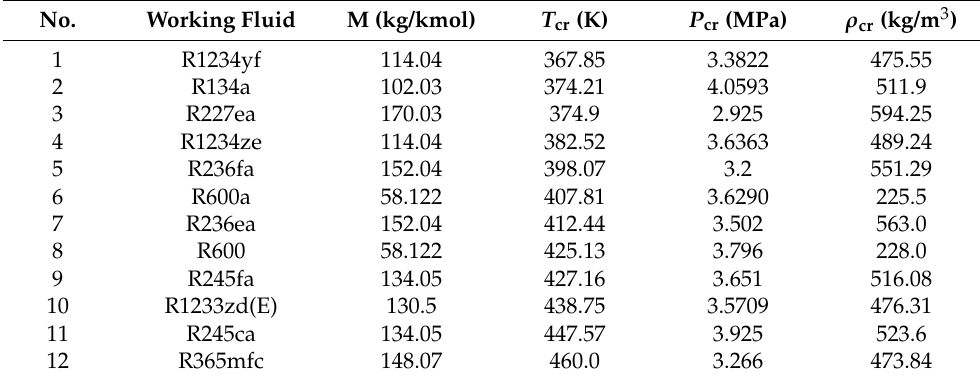
Table 2. The constant parameters assumed for system performance calculation.